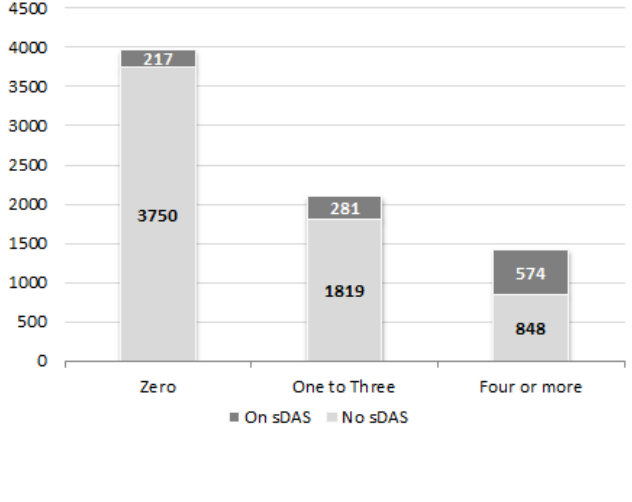
Figure 2: Relationship between GHQ-12 scores (0, 1-3 and >4) and use of psychotropic